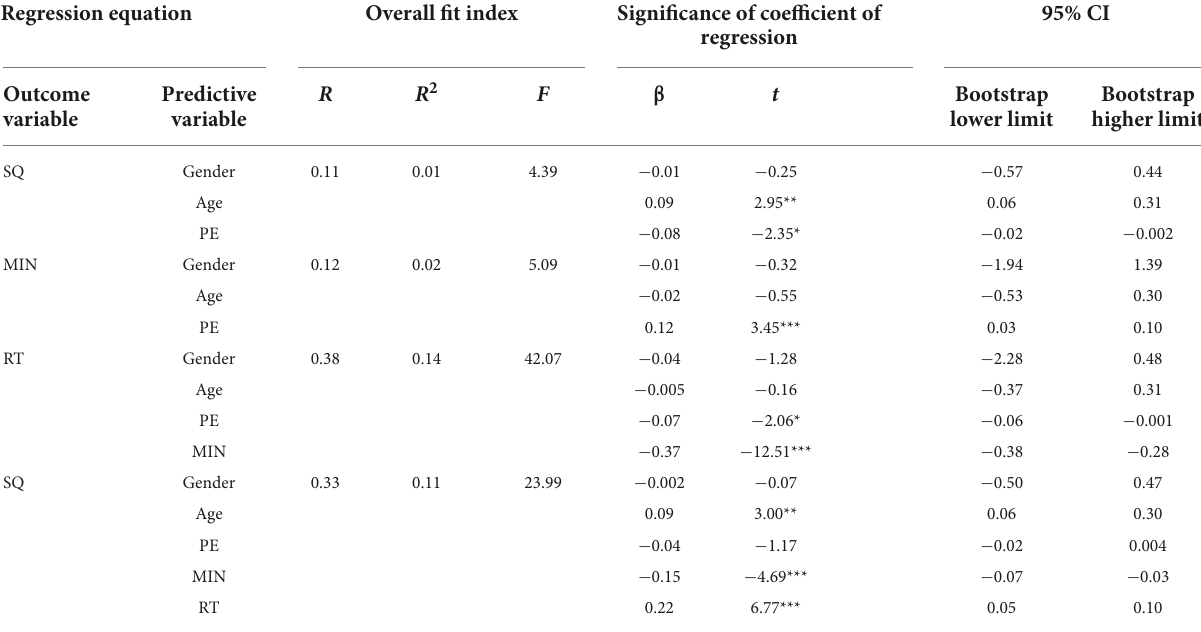
TABLE 2 Regression analysis of variable relationships.